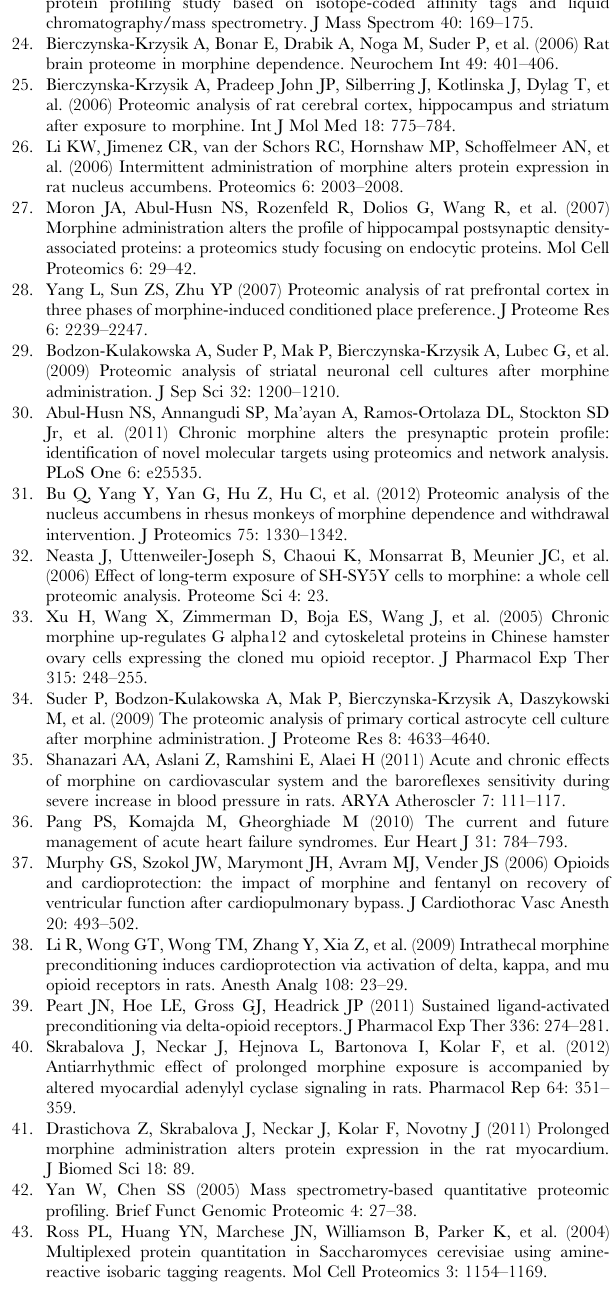
Table S2 Complete list of the myocardial proteins whose levels were not significantly altered after mor- phine treatment or withdrawal. The proteins whose expression levels were not significantly altered after morphine compared to controls were arranged according to their function into several groups. Number of accession (gi numbers